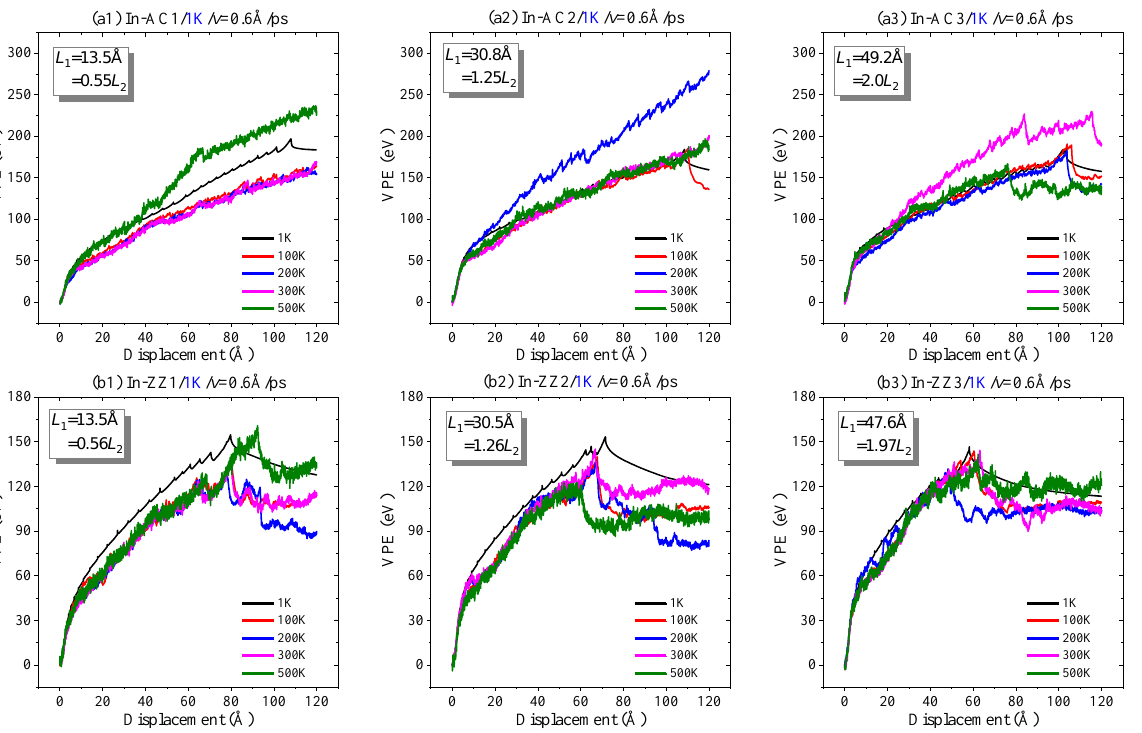
Figure 8. Curves of VPE vs. the in-plane tearing displacement of graphene sheets with v = 0.6 Å/ps at different temperatures: ( a1 – a3 ) an armchair crack in the sheet, ( b1 – b3 ) a zigzag crack in the sheet. When tearing along the armchair crack (Figure 8a), some of the curves are aligned very well before the graphene sheet breaks. For example, the curves in In-AC1 have a small gap when the temperature is between 100 K and 300 K. In the In-AC2 case, the curves (except that at 200 K) have small gaps. In the In-AC3 case, only the curve at 300 K has an obvious gap with the remaining curves. By observing the snapshots of the sheet in the three cases (Figure 9), we found that the crack mainly propagated along with P(30 ◦ ) or P( − 30 ◦ ),